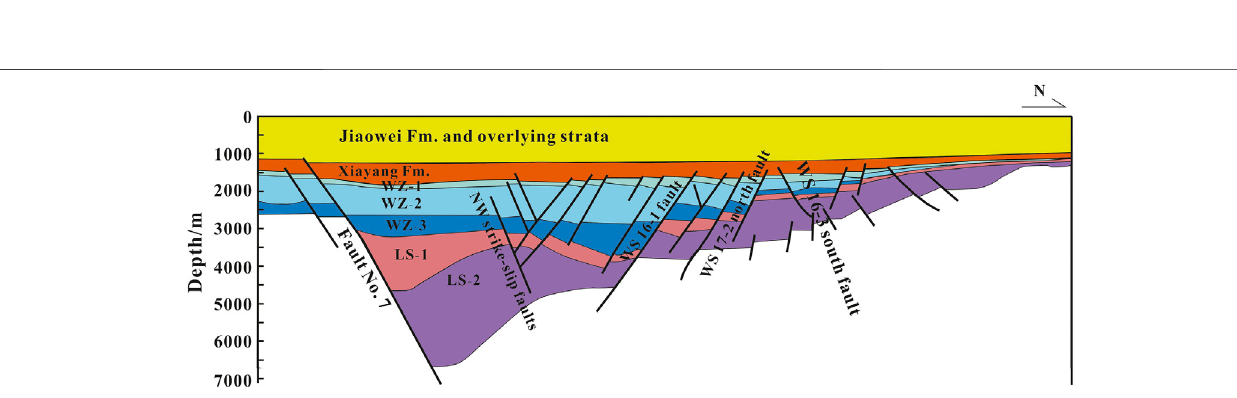
Frontiers in Earth Science |